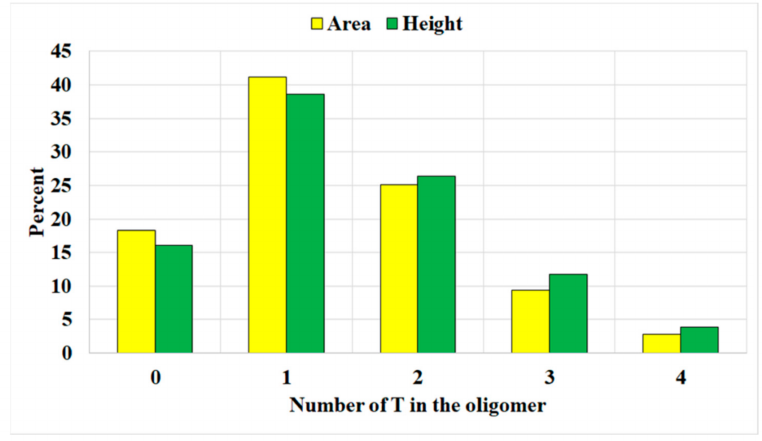
Figure 4. Distribution of terephthalate unit numbers in the molecule as determined by the area or height of the peaks in the total ion current